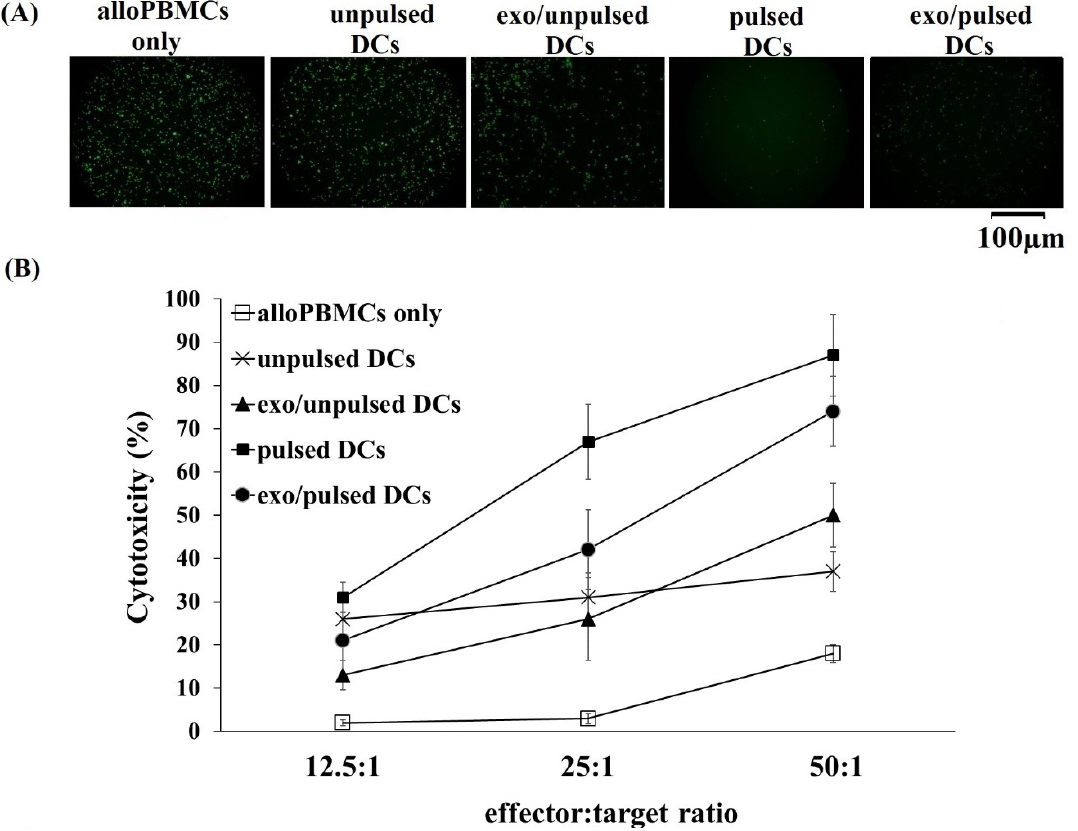
Figure 4. Cytotoxic activity of alloPBMCs in A549 lung cancer cells induced by DCs and DC ‐ derived exosomes. ( A ) Calcein ‐ AM ‐ labeled A549 cancer cells were observed as green fluorescent dots. The signal clearly decreased in wells containing A549 cells incubated with pulsed DCs, exo/pulsed DCs and exo/unpulsed DCs ‐ primed alloPBMCs (at an E:T ratio of 50:1). In contrast, no change was observed in wells containing A549 cells incubated with unprimed ‐ alloPBMCs. ( B ) Cytotoxicity in A549 cells induced by primed ‐ alloPBMCs compared to that of unprimed ‐ alloPBMCs. Pulsed DCs and exo/pulsed DCs primed ‐ alloPBMCs were the most cytotoxic to A459 cells at all tested ratios. Interestingly, exosomes isolated from unpulsed DCs also induced alloPBMCs cytotoxicity against cancer cells. ( C ) Cytotoxicity in A549 cells induced by primed ‐ alloT cells compared to that of unprimed ‐ alloT cells. Both pulsed DCs and exo/pulsed DCs ‐ primed alloT cells had greater effect on